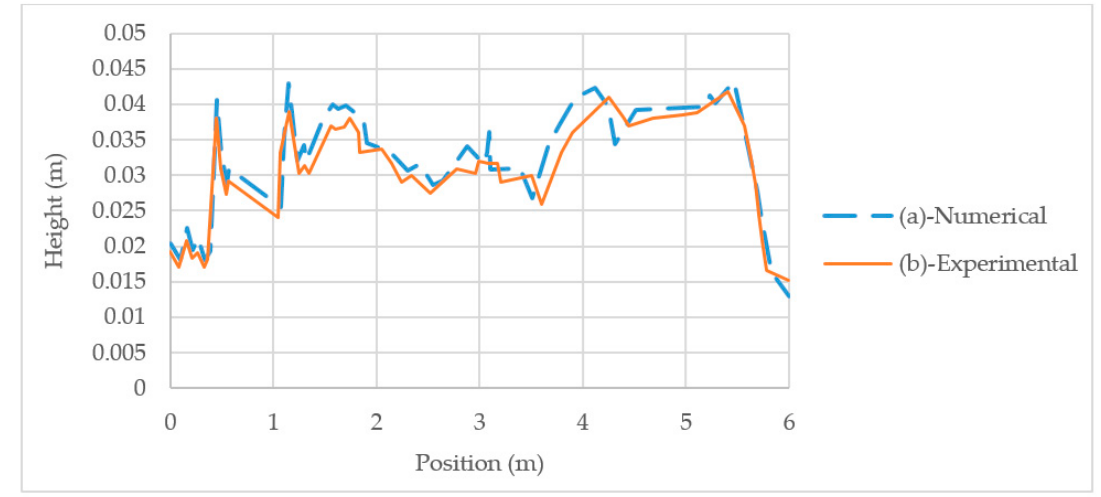
Figure 3. Profile of deposition in the reservoir for ( a ) numerical and ( b ) experimental data [35].